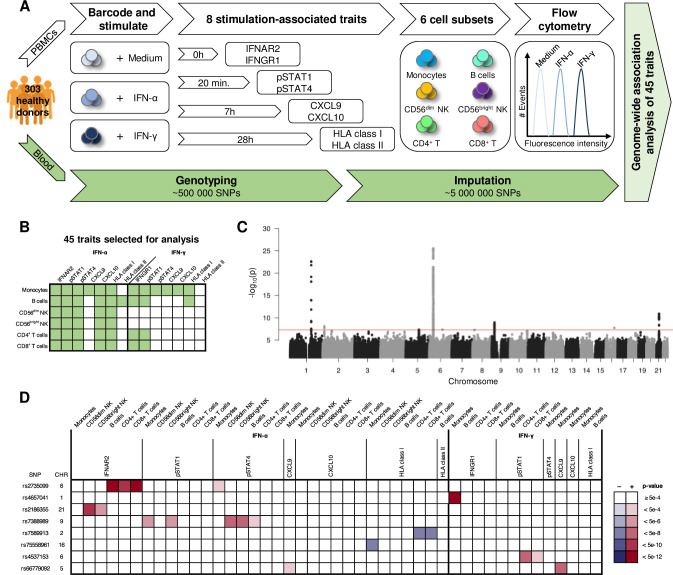
pQTL analysis of IFN-α and IFN-γ receptor levels and responses.(A) Schematic overview of the study design. For detailed experimental procedures see the Methods section. (B) Depiction of the 45 traits selected for pQTL analysis marked in green. (C) A combined Manhattan plot of the 45 pQTL analyses with the lowest p-value for each SNP depicted in the plot. The red line denotes the genome-wide significance level of p < 5.0E-8. (D) A heat-map with p-values of the eight genome-wide significant SNPs for all 45 traits studied. Blue indicates a decrease in minor allele carriers, while red indicates an increase in minor allele carriers. (C and D) p-values from the full model as described in the Methods section. (n = 303).